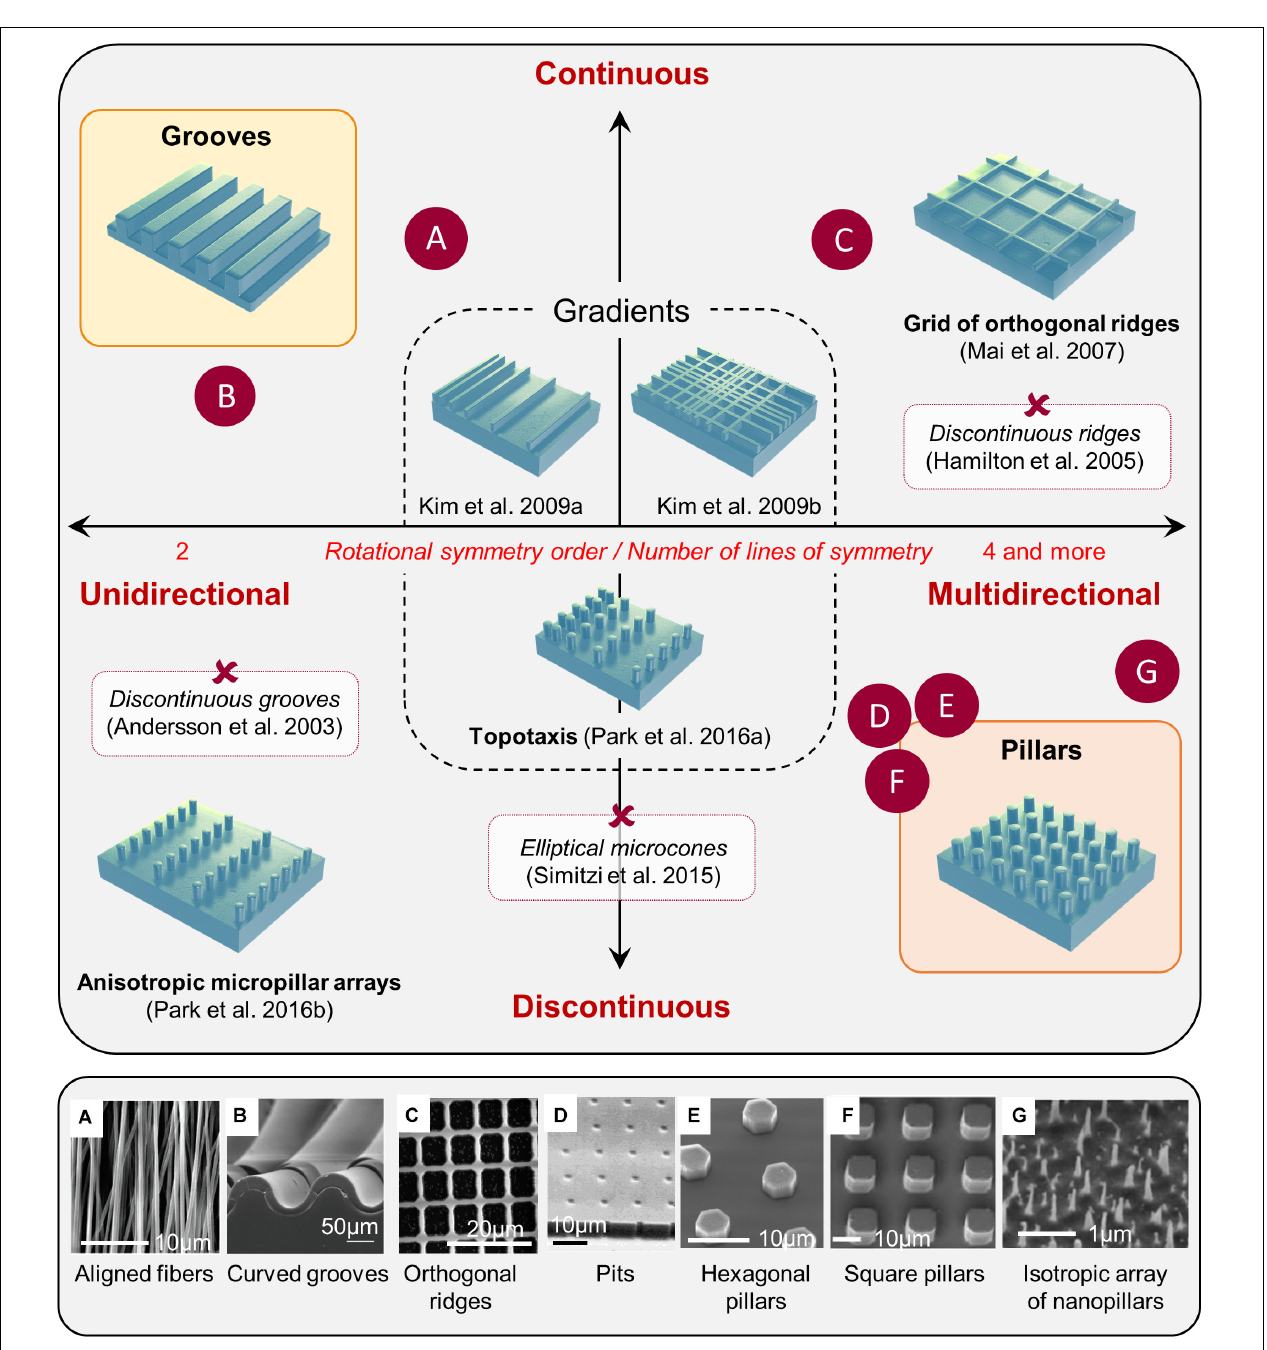
FIGURE 1 | Classification of microstructured substrates. Most microstructured substrates found in the literature can be classified according to its rotational symmetry order (unidirectional toward multidirectional), and the continuous or discontinuous nature of the topographical cues. Examples of various substrates mentioned in the review are positioned in the classification (red crosses), and some examples are illustrated in the bottom panel (letters): reproduced with permission from (A) Adapted with permission from Patel et al. (2007). Copyright 2007 Americal Chemical Society. (B) Tomba et al. (2019); (C) Kim et al. (2009b); (D) Tan et al. (2000); (E) Micholt et al. (2013); (F) Leclech et al. (2019). (G) Adapted with permission from Patel et al. (2007). Copyright 2007 Americal Chemical